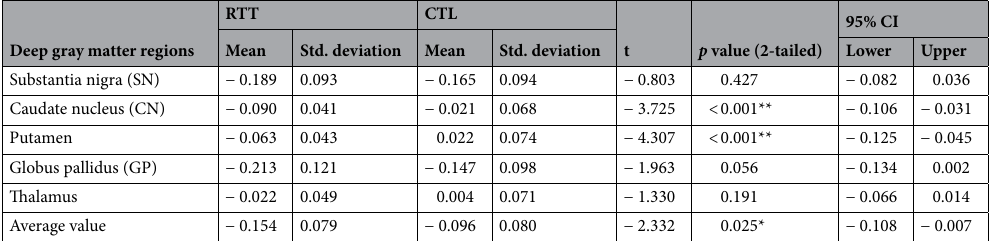
Table 2. Comparison of contrast ratio in five deep gray matter between patients with Rett syndrome and controls. Average value: average values of SN, PU and GP. * p < 0.05, ** p < 0.001. Adjusted for multiple comparison with Benjamini–Hochberg correction.